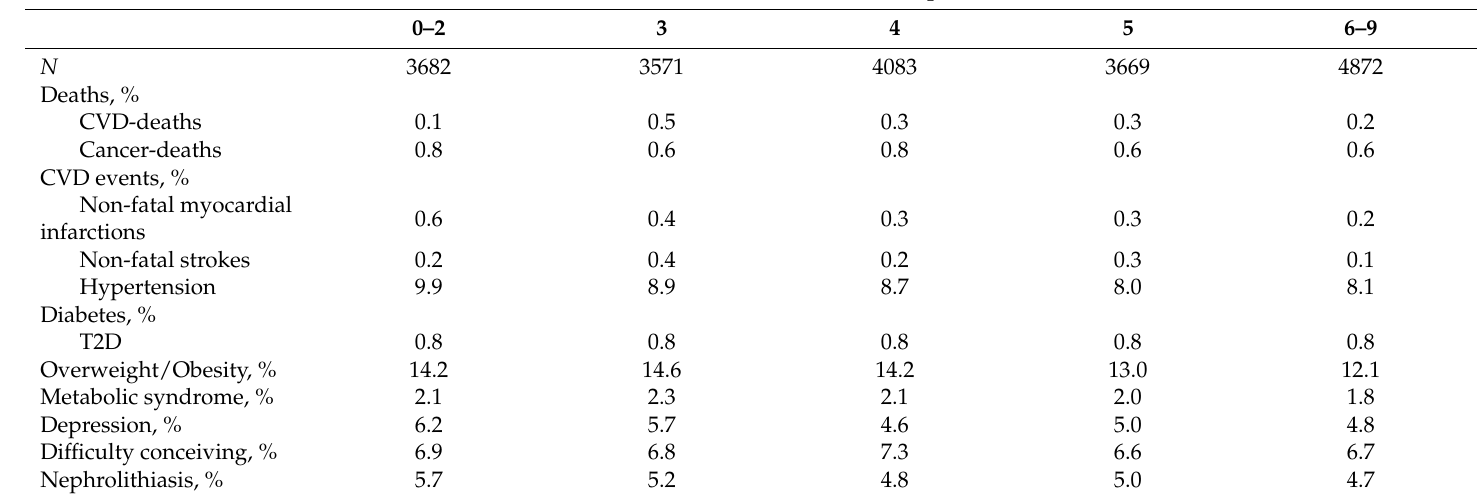
Table 3. Incident outcomes according to quintiles of adherence to the Mediterranean diet (MedDiet) in the SUN Project adjusted for age and sex using inverse probability